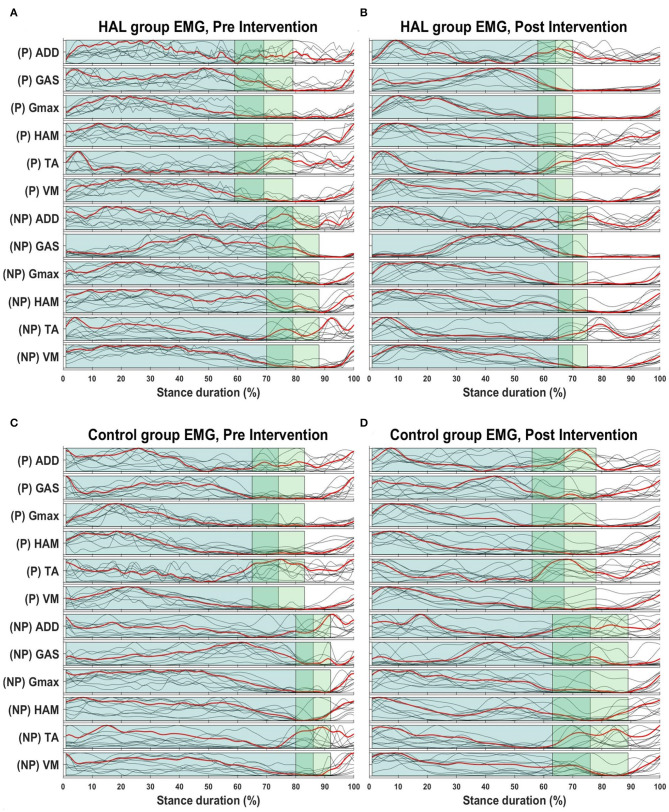
Overview of EMG envelopes and stance percentage. Overview of changes in stance percentage and EMG waveform for both HAL (A,B) and Control group (C,D). Dark green shaded areas represent the mean stance percentage for all patients in their respective groups, while the lighter green areas represent the standard deviation. Red lines indicate the mean EMG amplitudes for the all patients in their respective groups, while the gray lines represents mean EMG waveform from each patient.